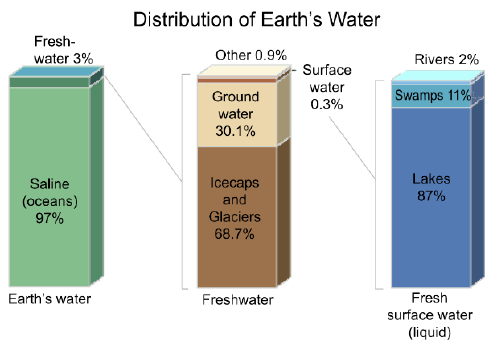
Figure1. A graphical distribution of the locations of water on